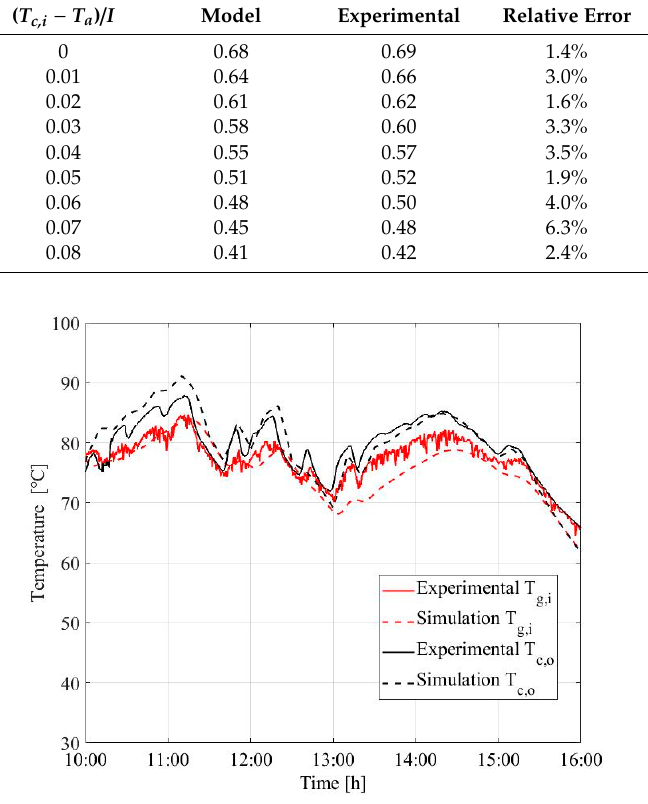
Table 1. Validation of the ETC model.